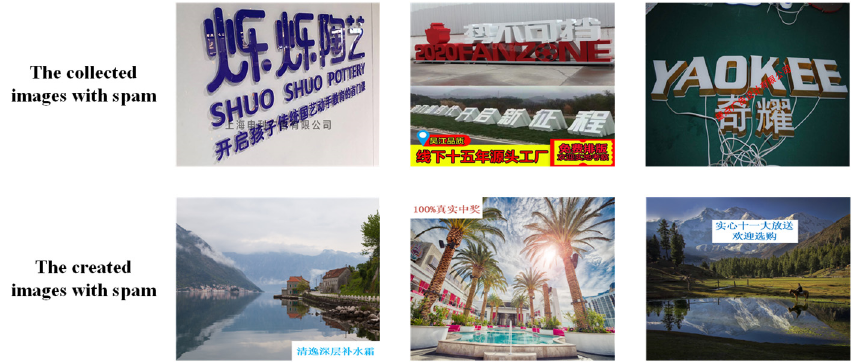
Figure 2. Example training images from the collected and created image dataset.